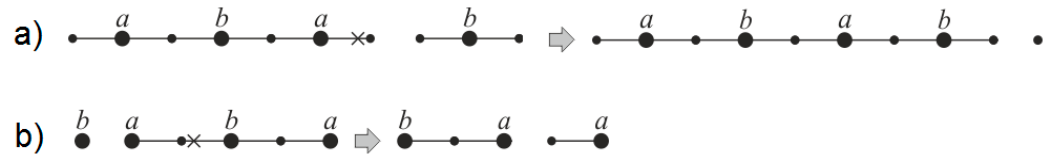
Figure 2. Interactions 3 a* + 3 b’ = 3 and 2 a’ + 2 b* = 2 + 1 ’ a . In both cases, s esquialteral intermerging (SM) is applied.